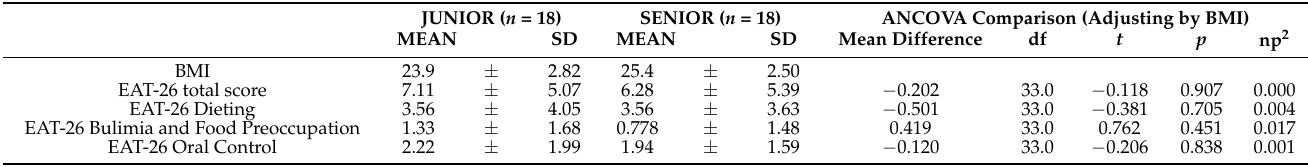
Table 3. Male BH players descriptive and comparison different EAT-26 subscales (junior vs. senior). JUNIOR ( n = 18) SENIOR ( n = 18) ANCOVA Comparison (Adjusting by BMI)